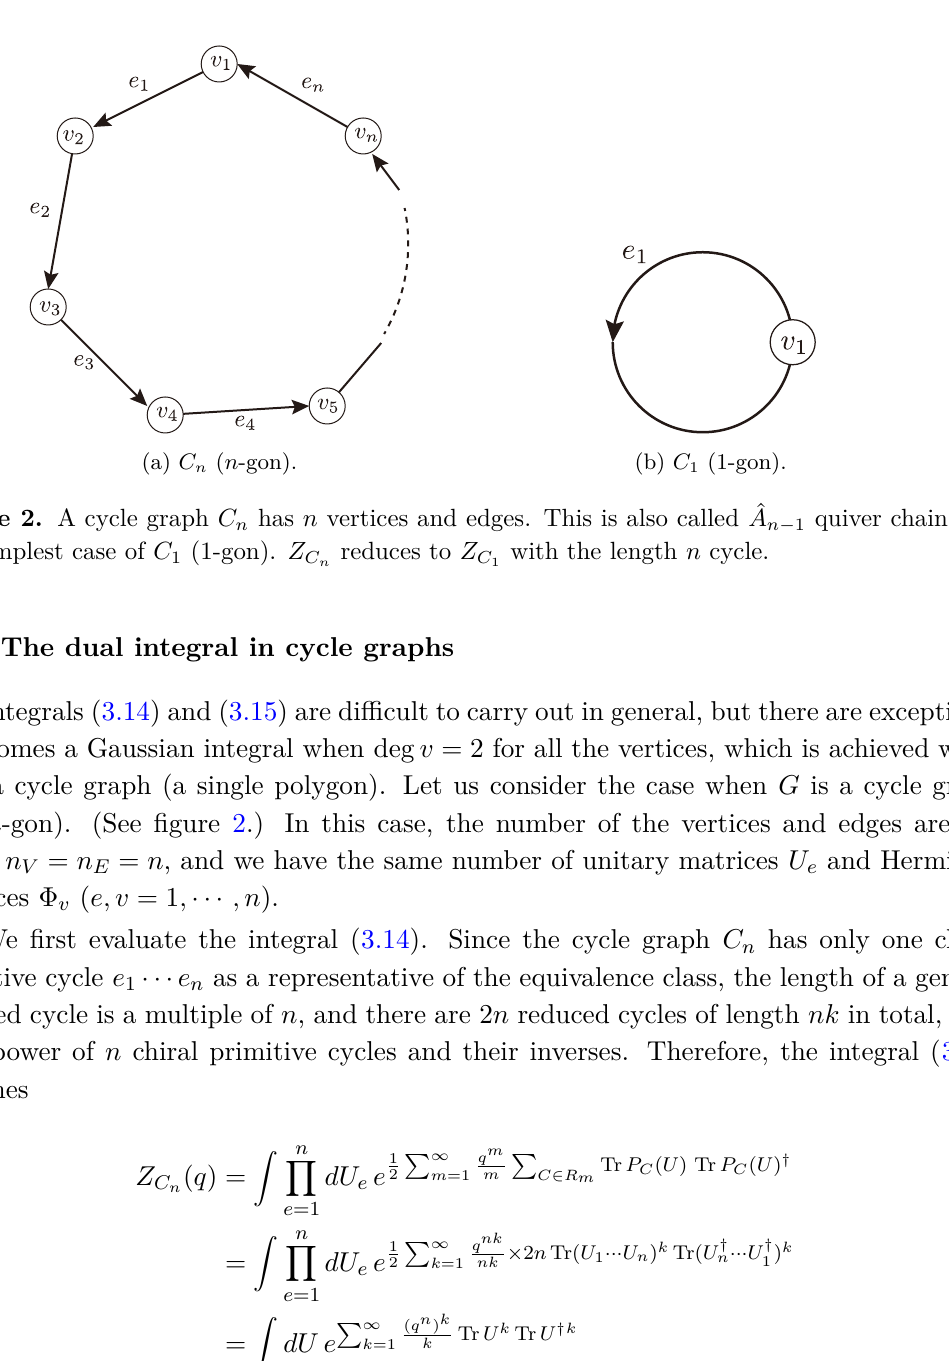
reduces to Z C with the length n n 1